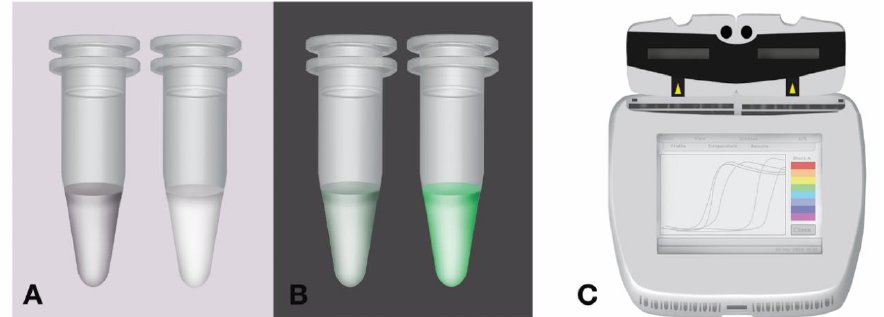
Figure 3. Schematic naked-eye visualization strategy of LAMP reaction. ( A ) Detection of LAMP reaction by turbidity. Left tube, without turbidity (negative); right tube, with turbidity (positive); ( B ) detection of LAMP reaction by fluorescence using calcein. Left tube, without green color (negative); right tube, with green color (positive); ( C ) real-time detection of LAMP reaction using a portable equipment like Genie ® II. The equipment is portable and robust for point of care testing and it